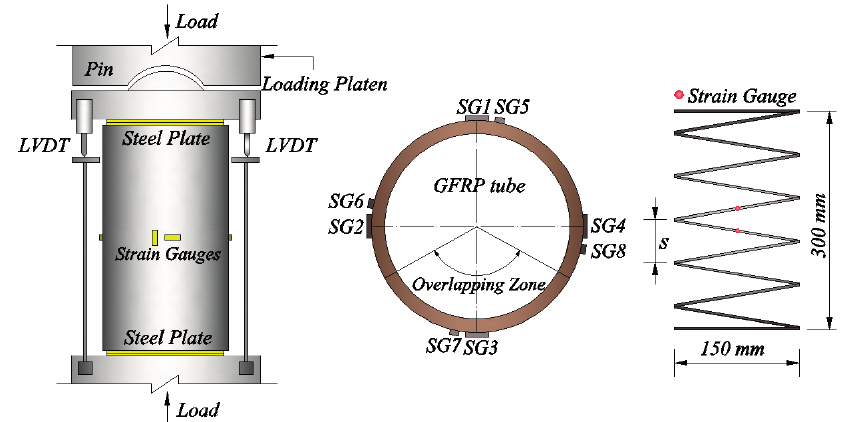
Figure 5. Test set-up and instrumentation